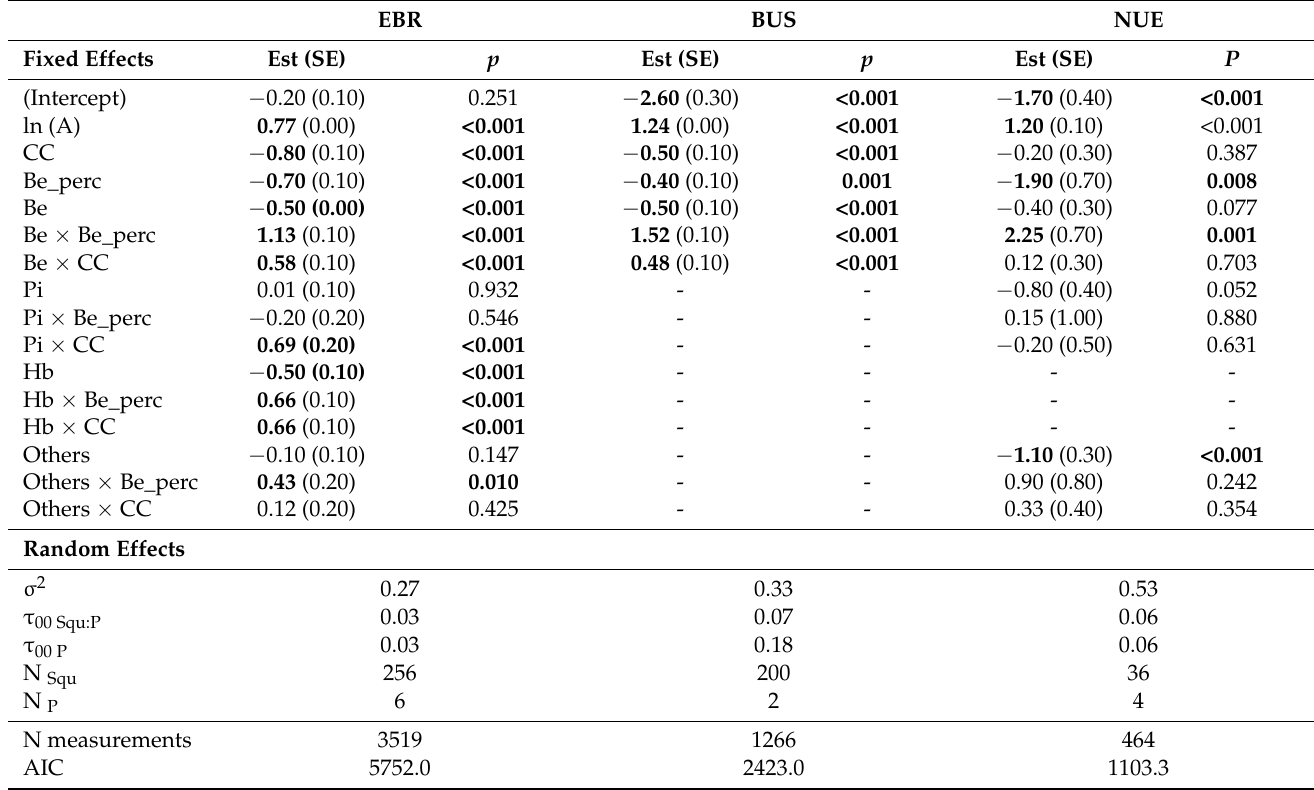
Table 6. Results on the height model as a function of regeneration age (A), canopy cover (CC), and proportion of beech regeneration (BE_perc) (Equation (5)); the reference species is oak; Est—estimated value; SE—standard error; p — p -value. Significant values are written in bold. EBR BUS